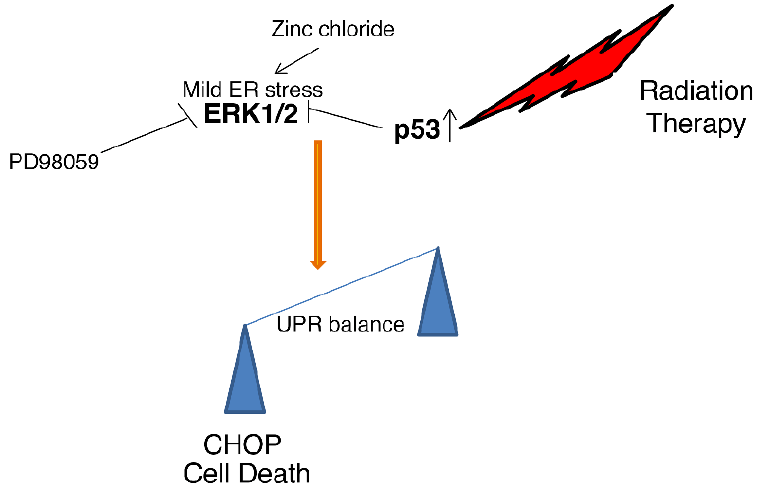
Figure 5. Representative scheme illustrating how the interaction between wtp53 and ERK leads to UPR umbalance and cell death.